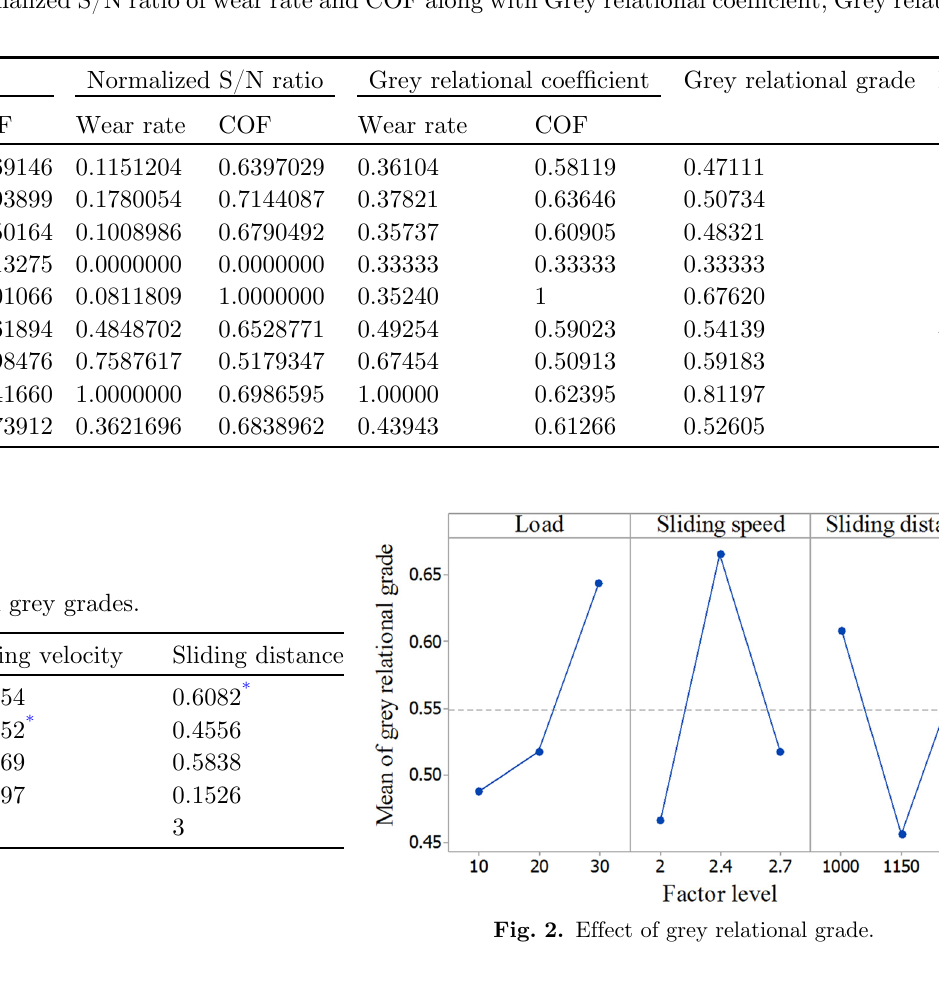
Table 7. Results of ANOVA on grey